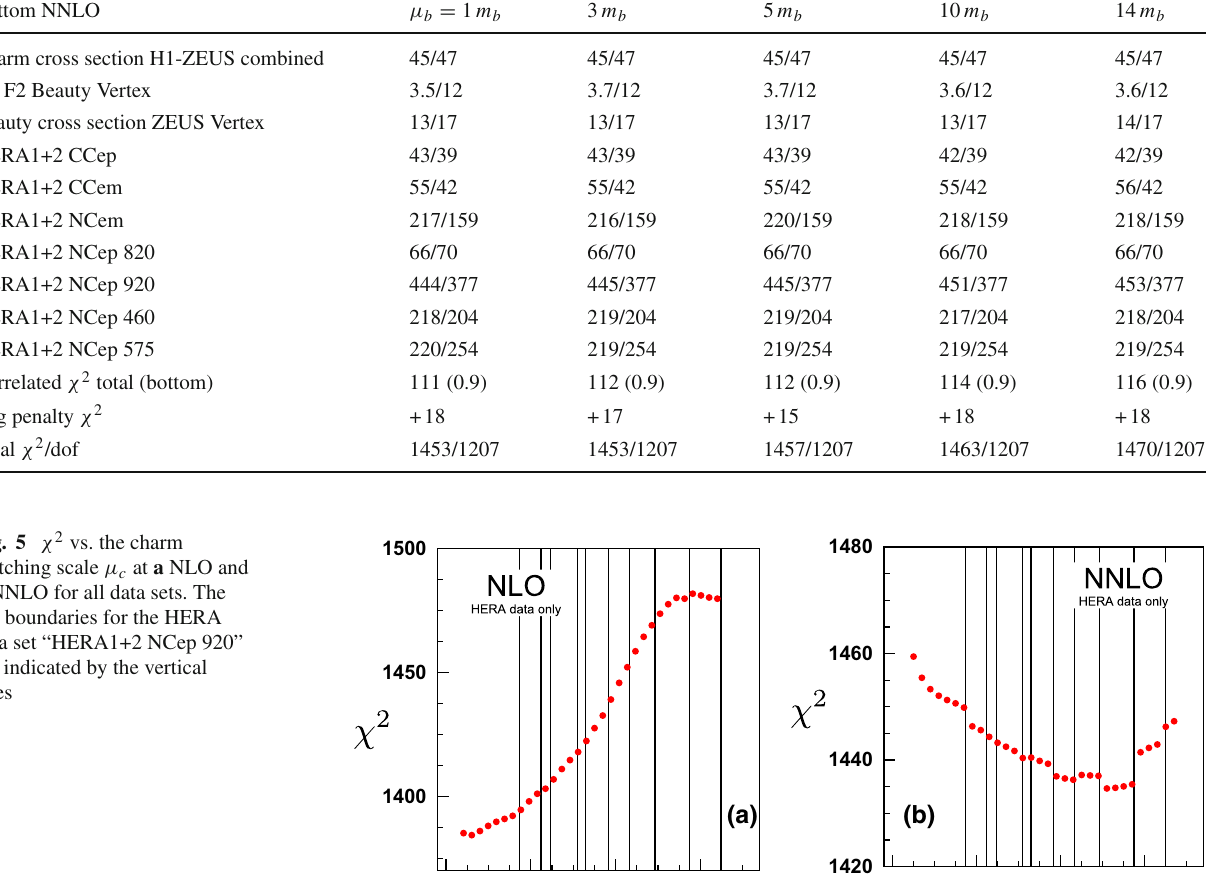
Table 4 The χ 2 values at NNLO for individual data sets for a selection of the bottom matching scales μ b . The contribution of the bottom data contained in the “Correlated χ 2 ” and in the “Log penalty χ 2 ” terms is indicated separately in the parentheses